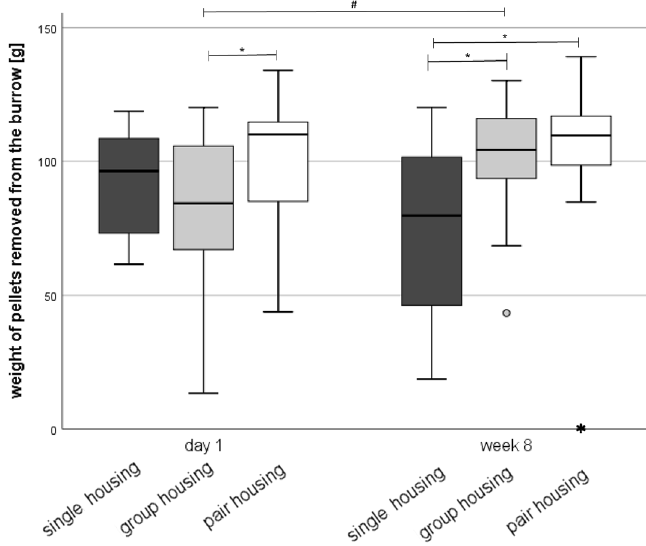
Figure 5. Burrowing performance. Data are presented as boxplot diagrams: the box represents the interquartile range (IQR), box edges are the 25th and 75th quartile. The whiskers represent values which are not greater than 1.5 × IQR. Dots are outliers with values between 1.5 ‒ 3.0 × IQR. Asterisks are outliers with values greater than 3.0 × IQR. Single housing: n = 15, group housing: n = 15, pair housing: n = 16. Overall, one single- and one group- housed mice were excluded from statistics because they removed less than 5 g food pellets from the burrow (non-responders). * p < 0.05 versus the other housing system; # p < 0.05 versus week 8.